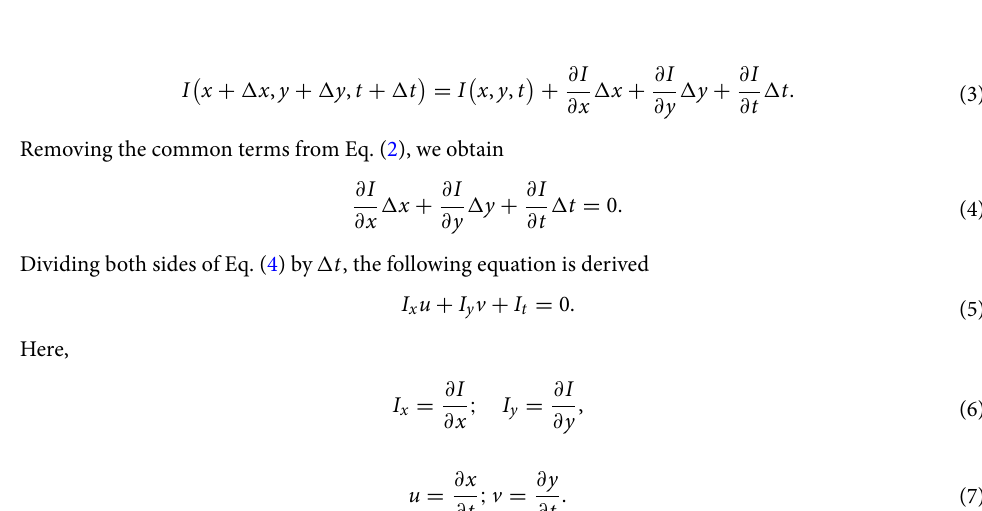
Figure 5. Conceptual diagram of the developed framework to assess dislocation